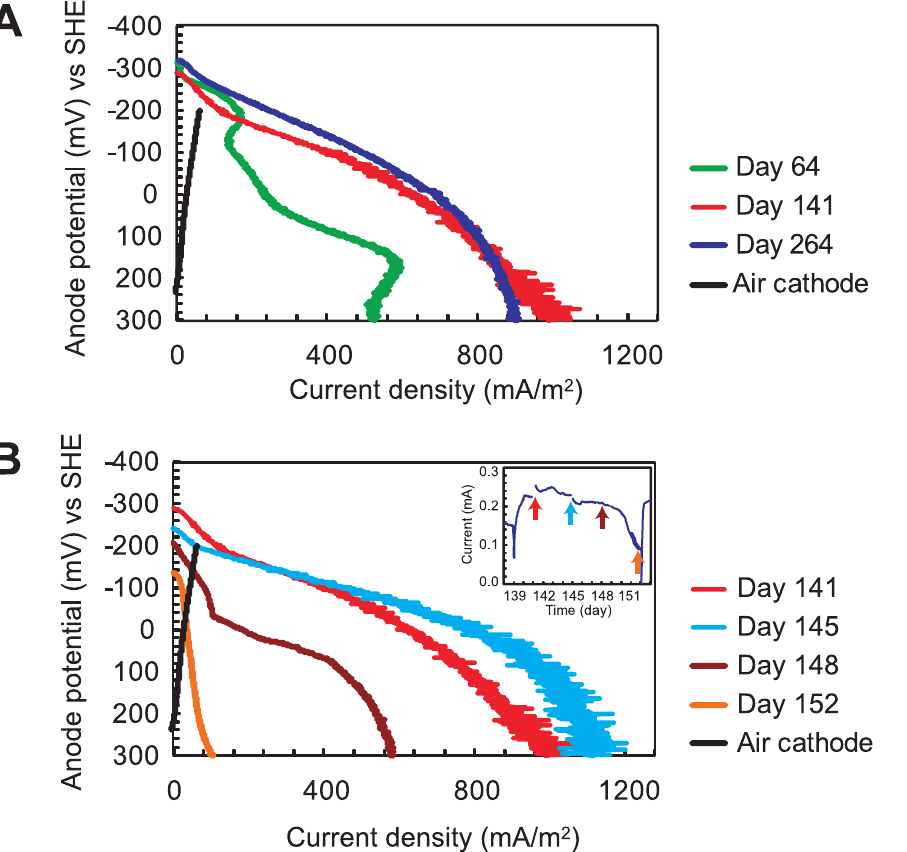
Figure 4. Anode polarization curves in the primary clarifier effluent-fed MFC determined by linear sweep voltammetry. The anode polarization curves during the enrichment process of electricity generating mixed community (A). The anode polarization curves during a single batch operation from day 139 to day 151, current generations are shown in the inset (B). Cathode polarization curve (black line) was determined on day 108.